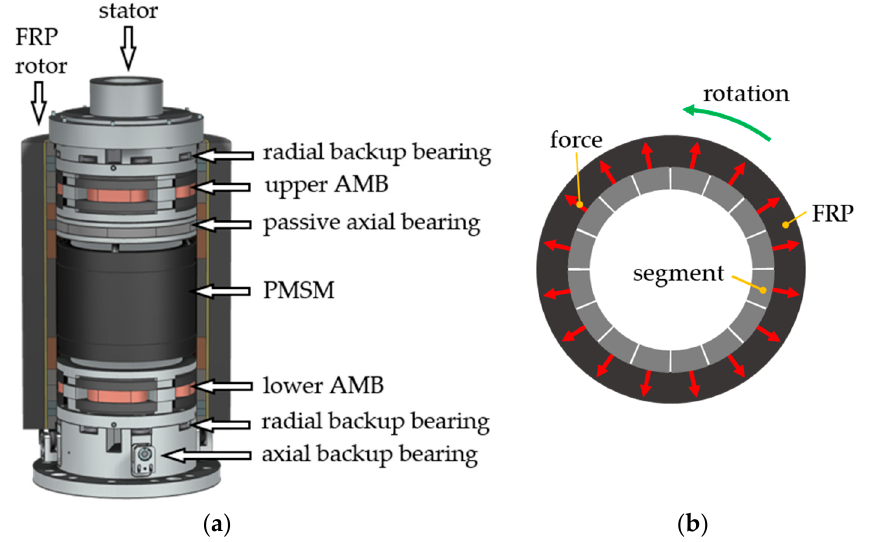
Figure 1. ( a ) Model the outer-rotor Flywheel described in [6] with a halved rotor; ( b ) Top view on the rotor showing the segments pressing against the fiber reinforced plastic (FRP) under